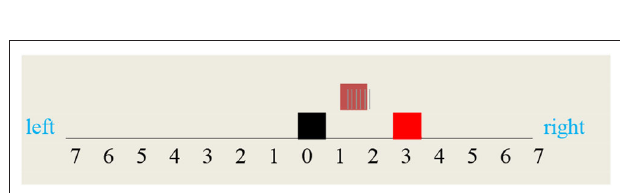
FIGURE 7 | Experiment configuration. The vehicle is at home , smoke at right, and a fire at right(3).